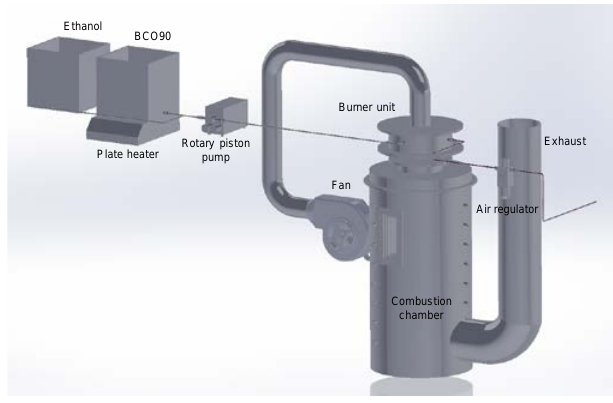
Figure 1. Bio-crude oil burner